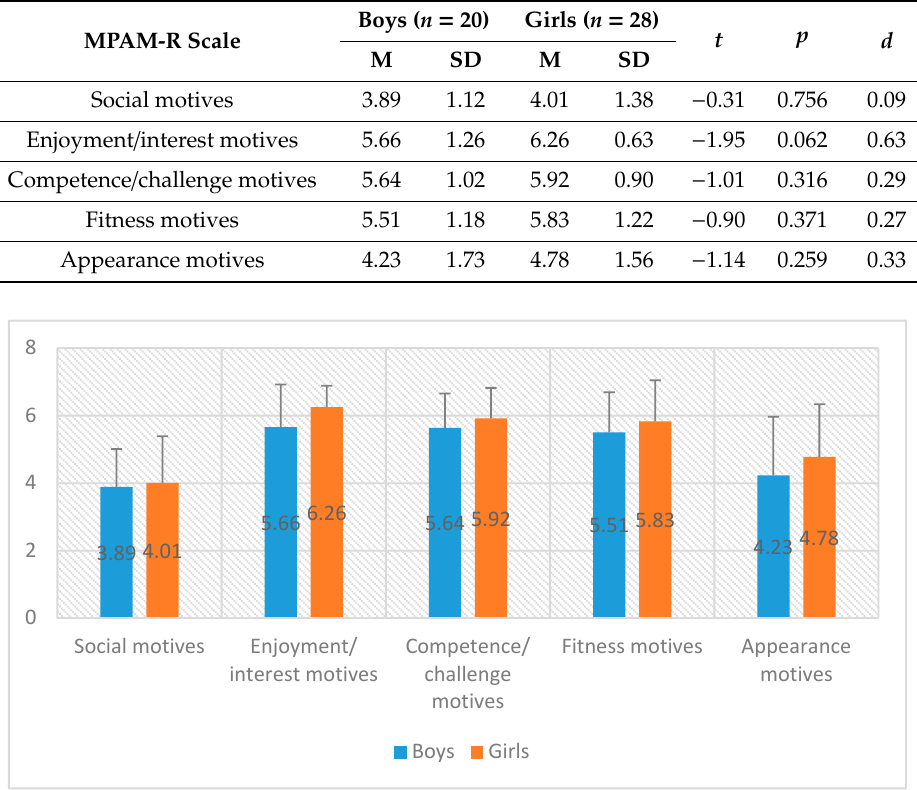
ff erences in motivation depending on gender. Figure 2. Differences in motivation depending on gender. Figure 2. Di Table 4. Motives of children who decided to start in the run themselves and at the instigation of Other